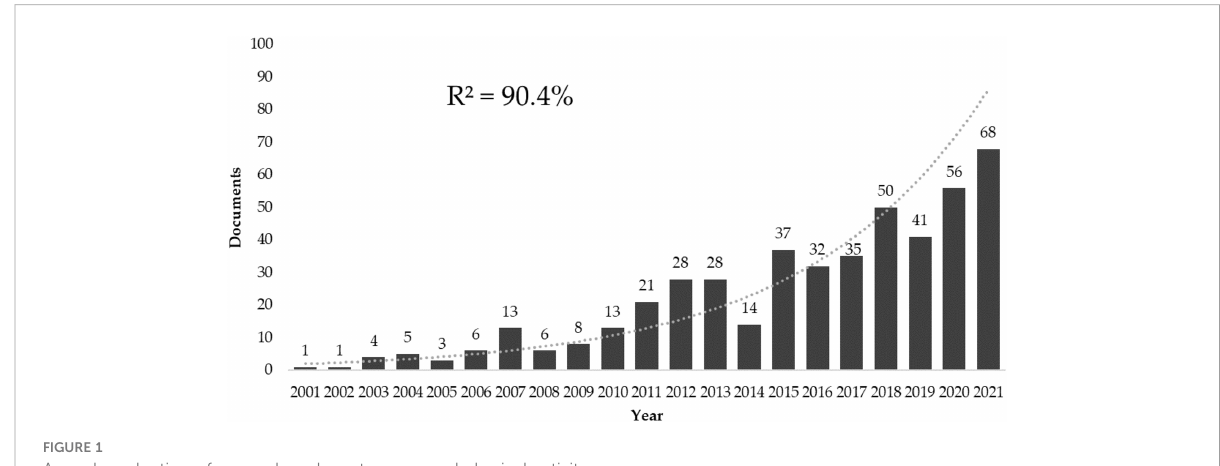
FIGURE 1 Annual production of research on breast cancer and physical activity.